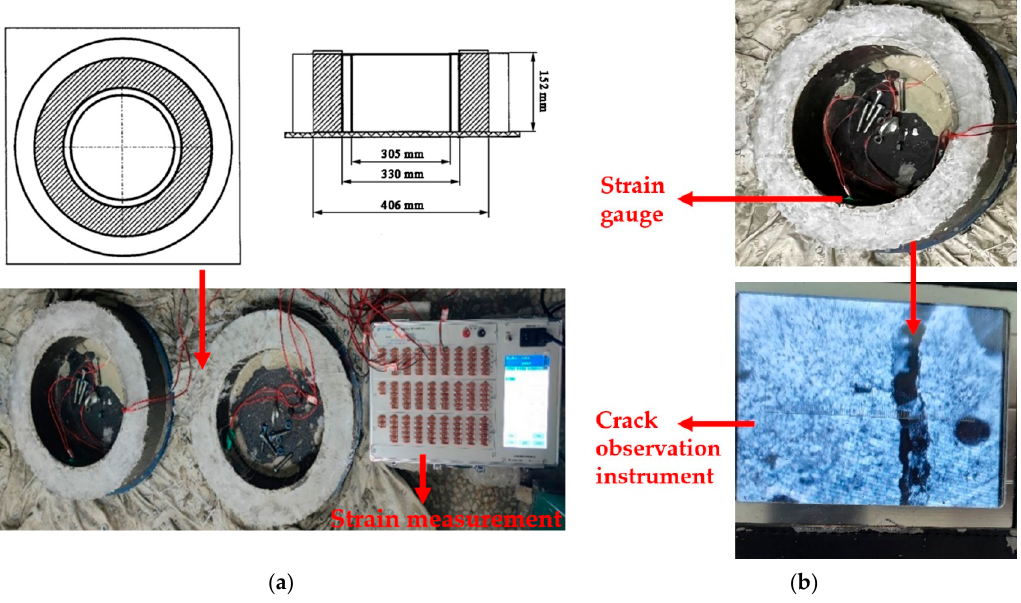
Figure 6. Restrained shrinkage flow. ( a ) Specimen preparation; ( b ) Crack width measurement. According to ASTM C 1581-04, the net cracking age t cr and the average stress rate S were used to evaluate the cracking resistance. The cracking age was easily obtained from a moment of an abrupt change in the strain–time curve. The crack number and crack distribution were recorded, and the crack observation instrument was used to measure the crack width, as shown in Figure 6b. Based on the test results, the net strain ε net was calculated as the difference between the strain in the steel ring at each recorded time and the initial time. The elapsed time t was calculated as the difference between each recorded time and the initial time. Plotting the net strain against the square root of the elapsed time for each strain gauge on the test specimen and using linear regression analysis to fit a straight line through the data. The strain rate factor was the slope of the line, according to Equation (3):